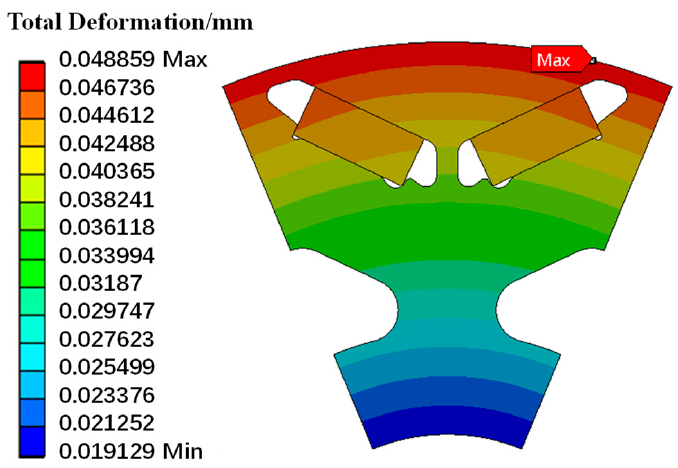
Figure 16. Rotor deformation under coupled thermomechanical fields.